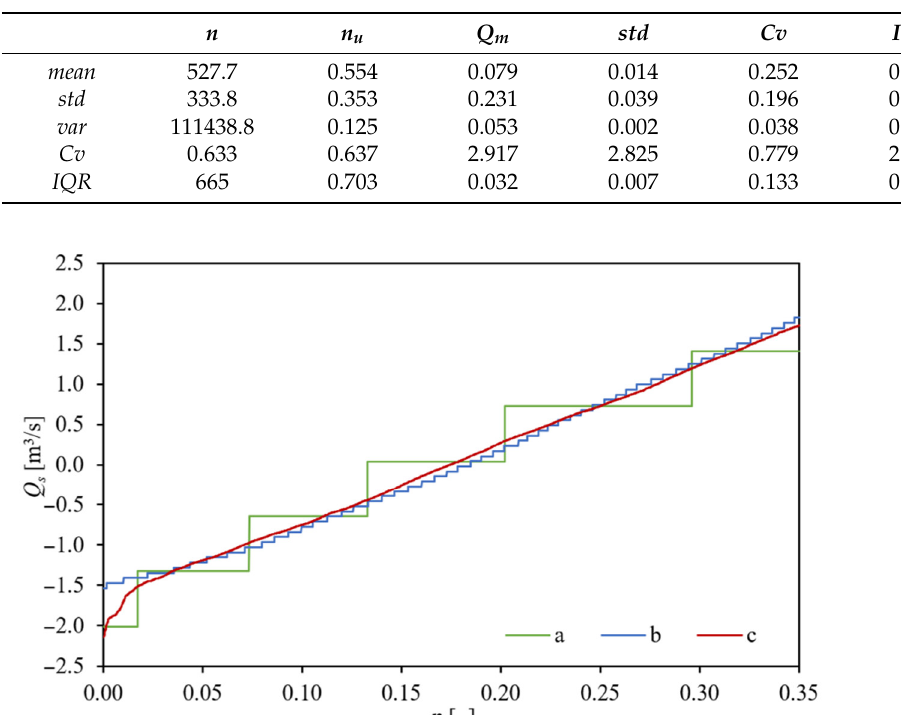
Figure 2. Example of standardized flow values ( Q s ) for the lower range (to 35th percentile) of the FDC for a sample series with high discretization ( a : unique values constitute less than 0.01% of the lower FDC range), moderate discretization ( b : unique values constitute 1% of the lower FDC range), and close to natural distribution ( c : unique values constitute around 90% of the lower FDC range).